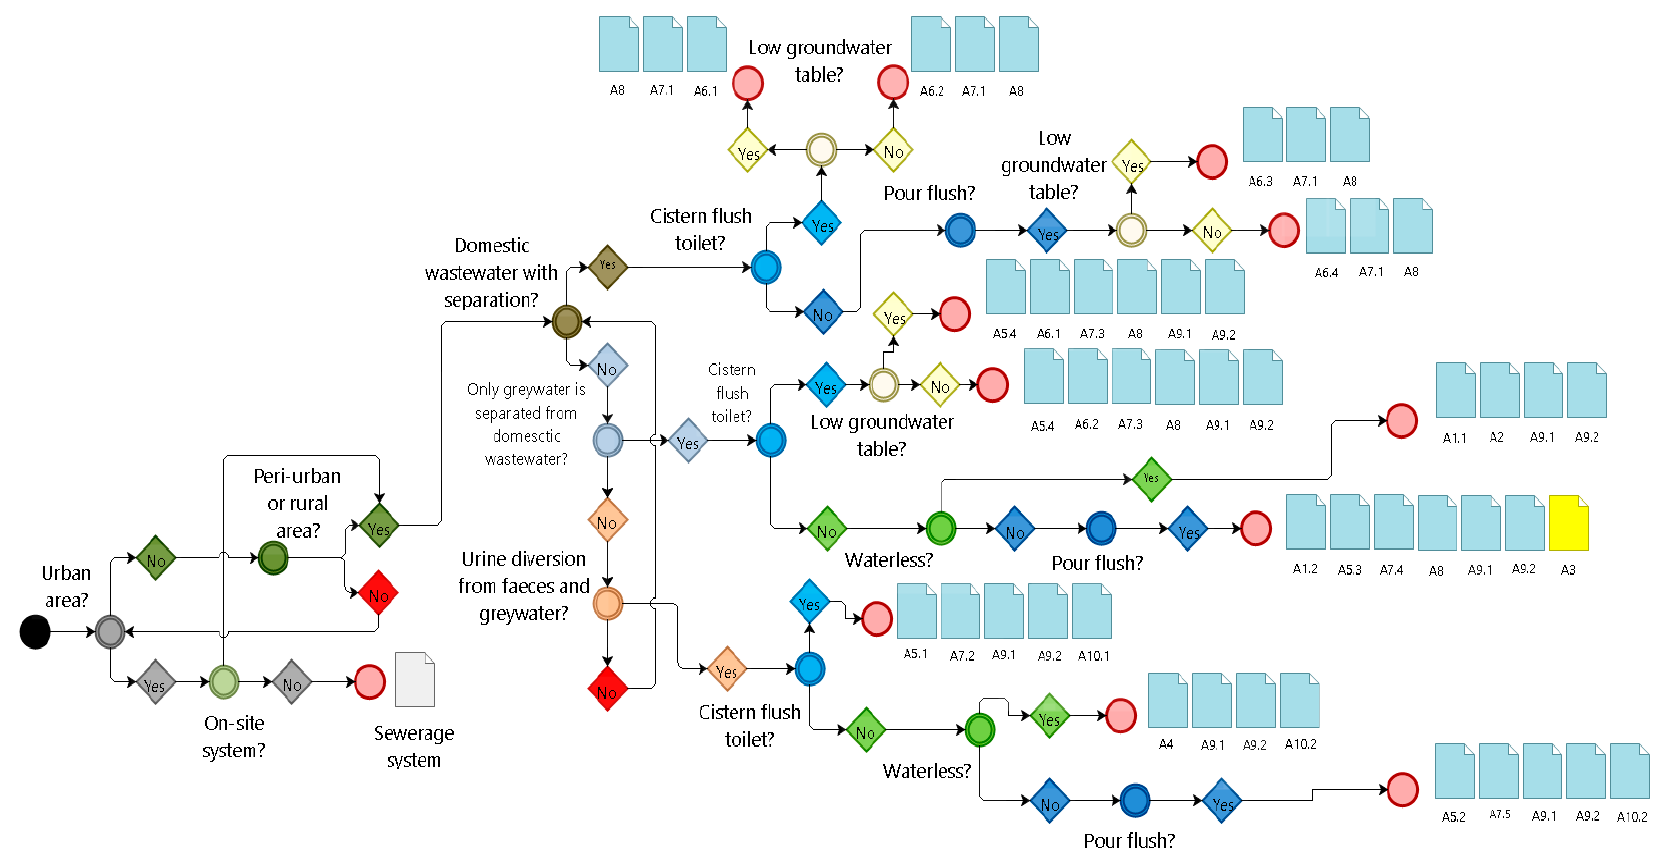
Figure 2. Decision tree based on class form linked to the database (BD II) with sanitation systems.